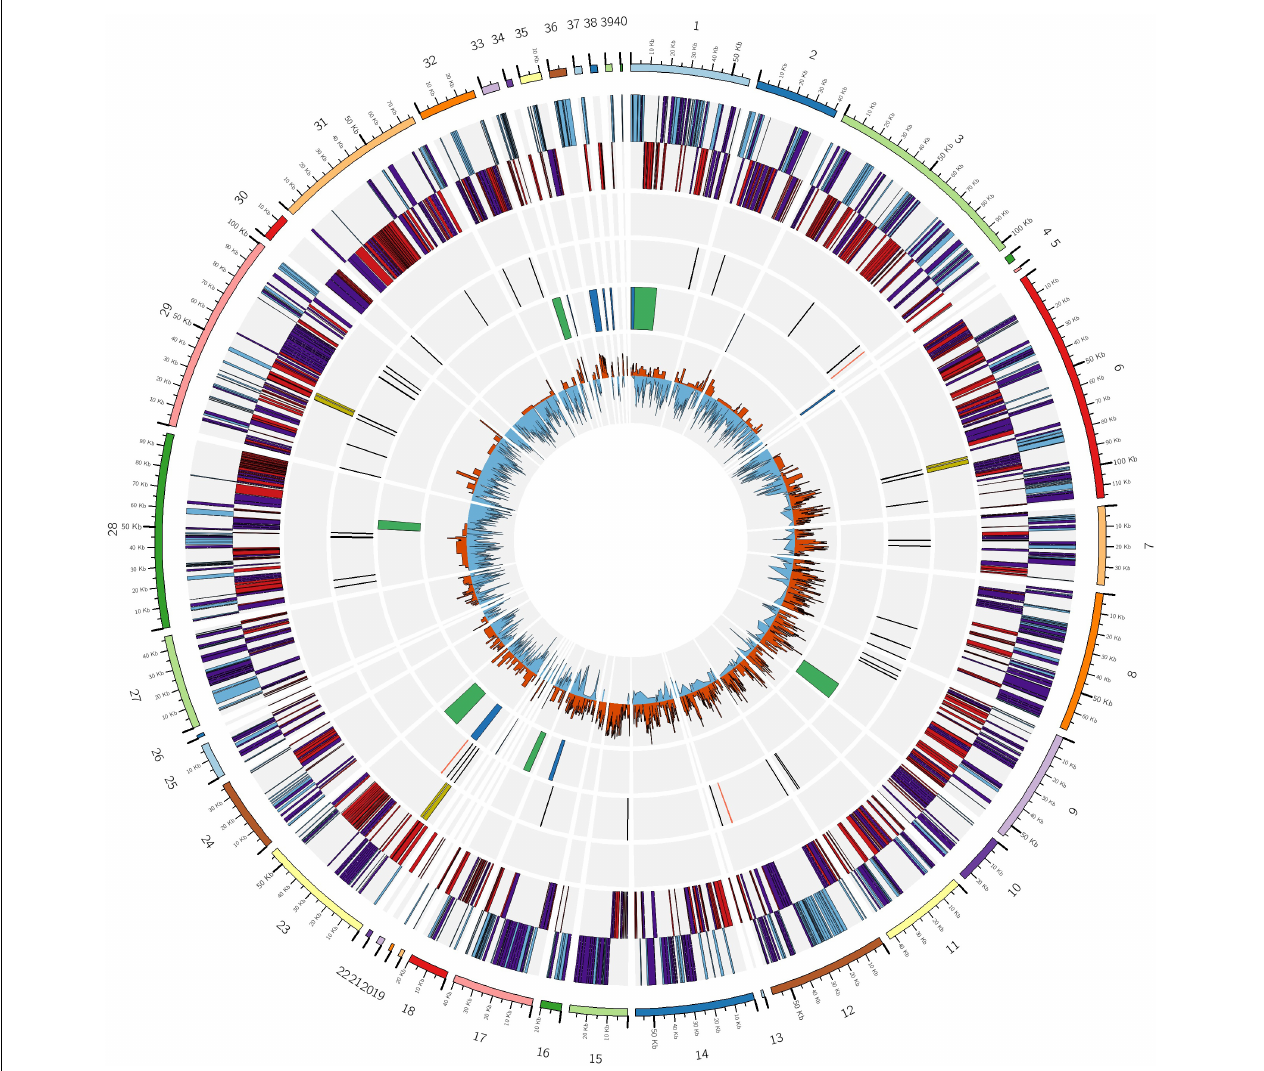
FIGURE 1 | Circular diagram of LsoD ISR100 genome. Descriptions of rings are from the outer to inner circle. (i) Contigs; (ii) protein coding genes in the positive (blue) and negative (red) strands. Enzymes in both strands are highlighted in purple; (iii) rRNA genes (yellow); (iv) tRNA (black lines) and other non-coding RNA (red lines); (v) prophage regions identified by PHASTER (green) and homologous (BLASTN) regions to Prophage P1 from LsoA (blue); and (vi) positive (orange) and negative (blue) GC-skew. Circular ideogram was plotted with CIRCOS (Krzywinski, 2009).